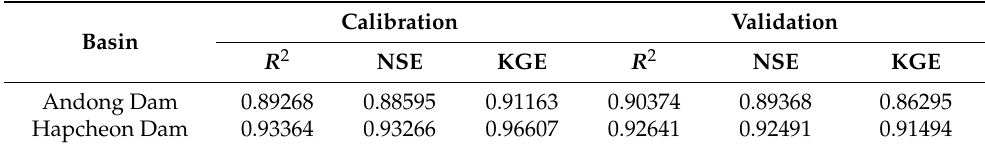
Table 2. Performance metrics of abcd model.